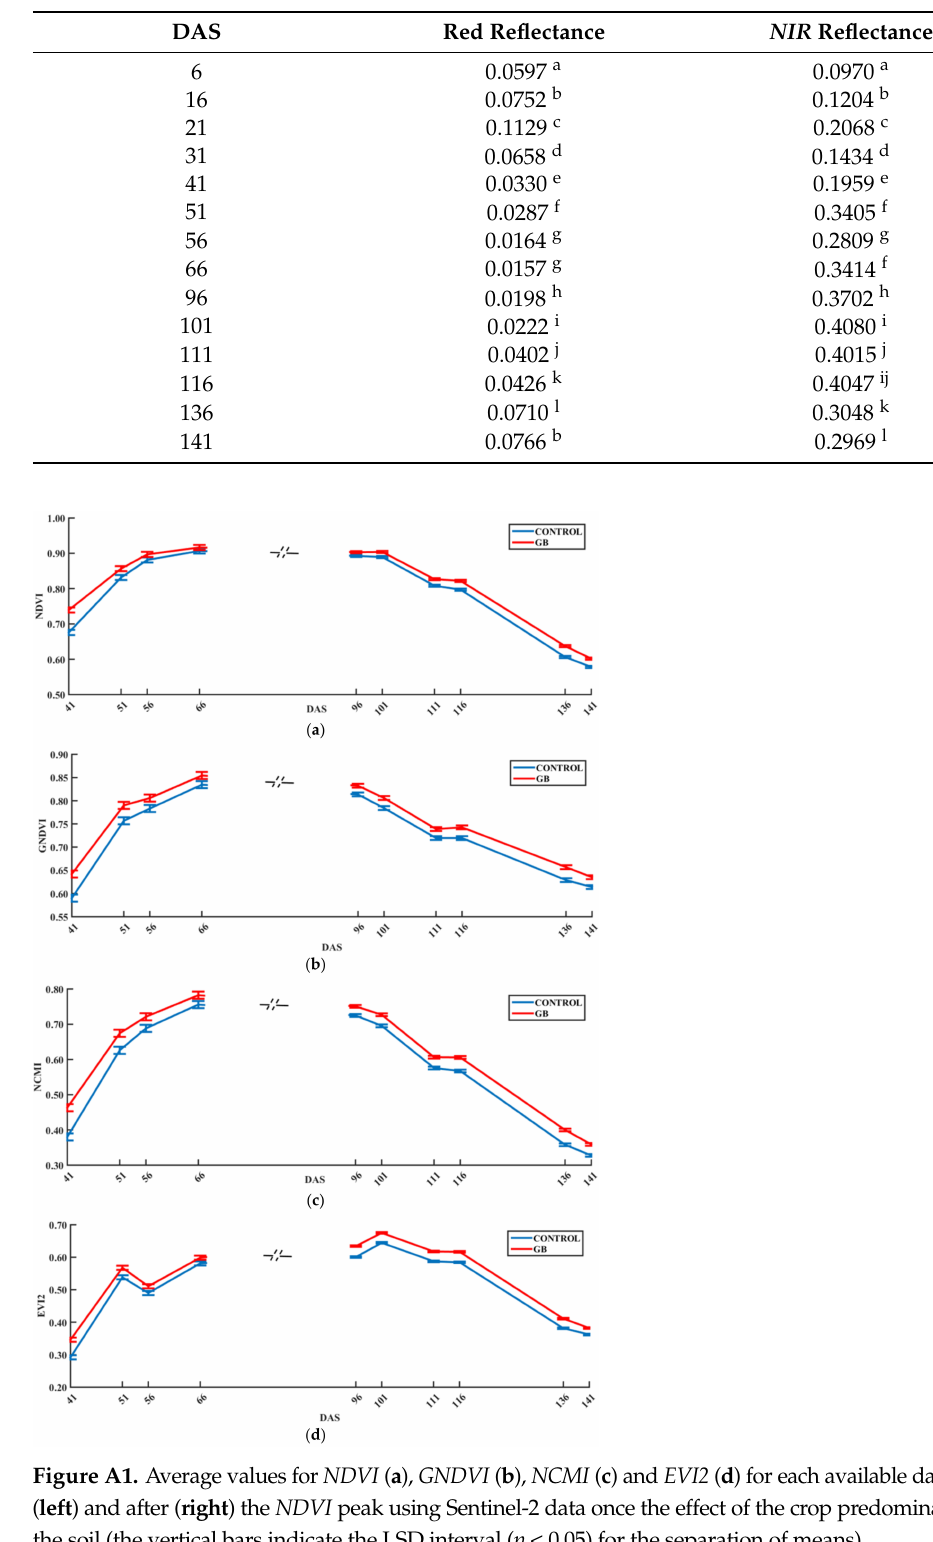
Table A1. Table of means of reflectances in the red and NIR bands over the whole crop cycle, combining control and GB. Different letters for each band indicate statistically significant differences between dates using the LSD test ( p < 0.05).